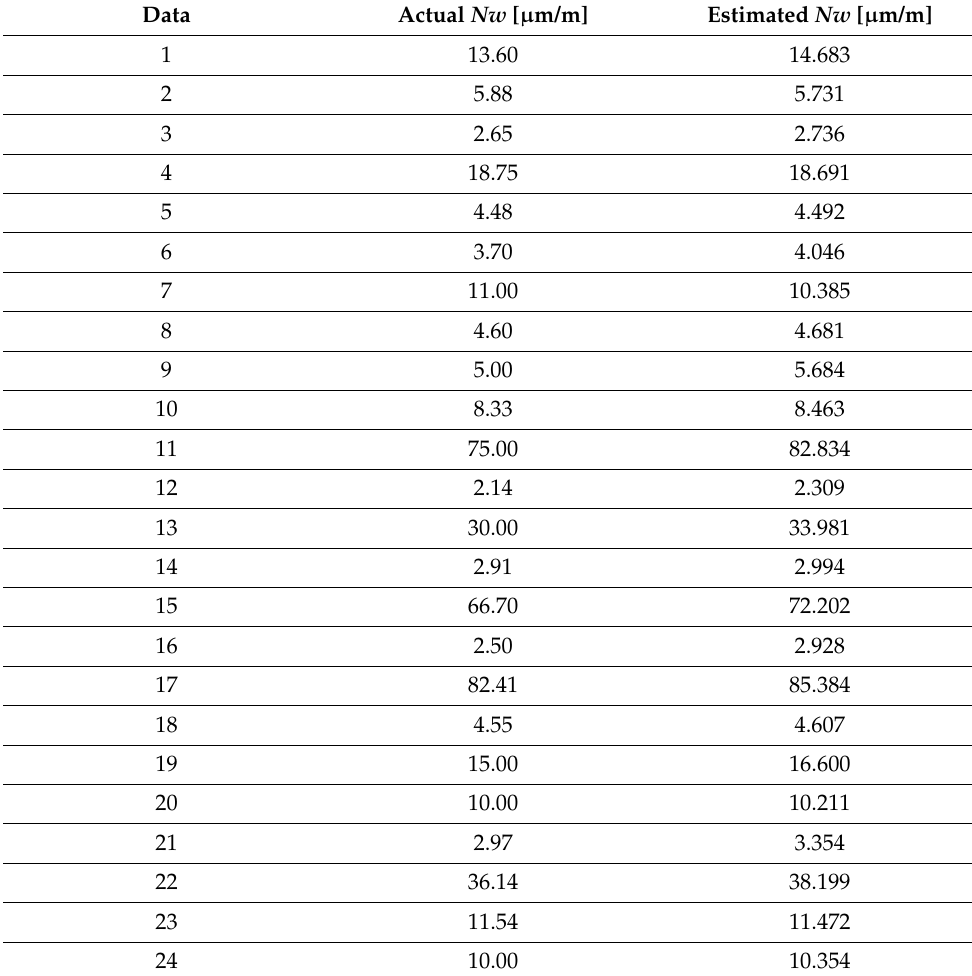
Table 4. The estimated cutting tool wear of the validation dataset.